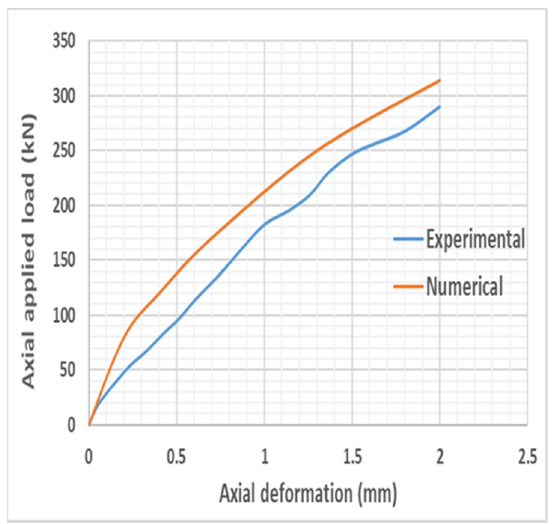
Figure 7: Numerical load - axial deformation of RC column with dif - ferent reinforcement ratios at